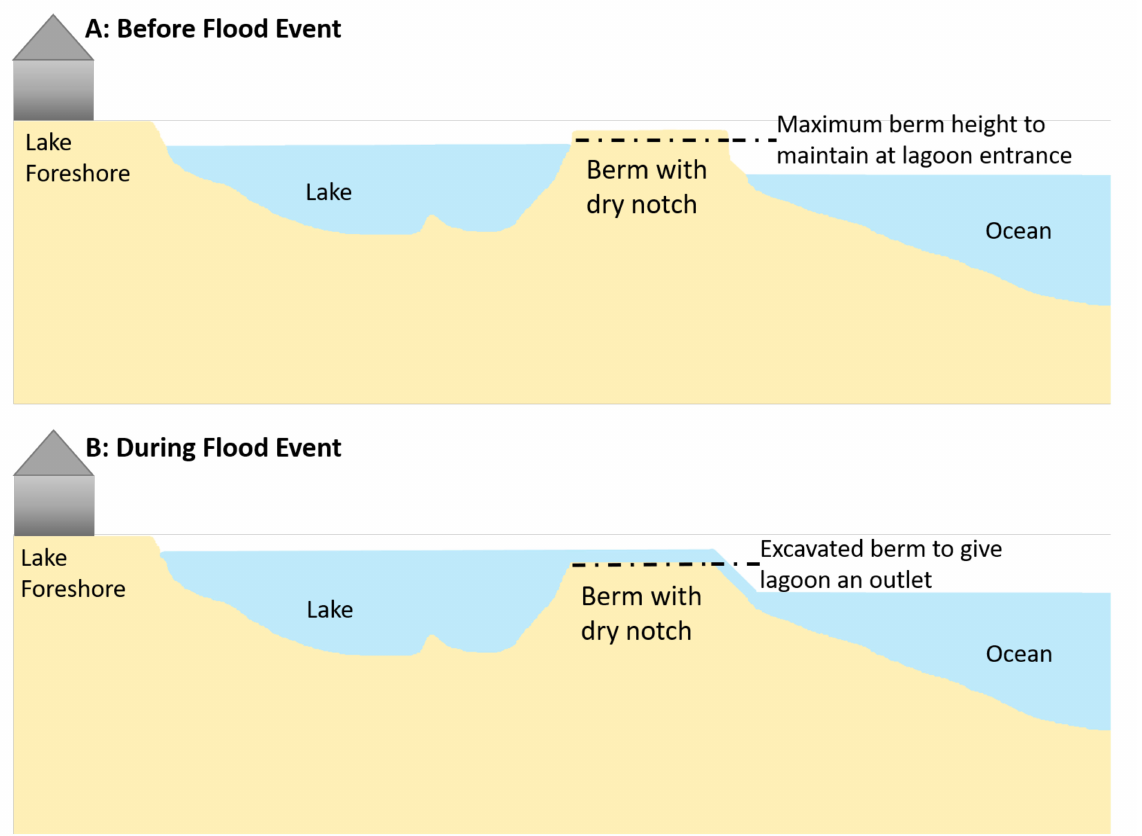
Figure 1. Importance of berm and dry notch management for lagoon